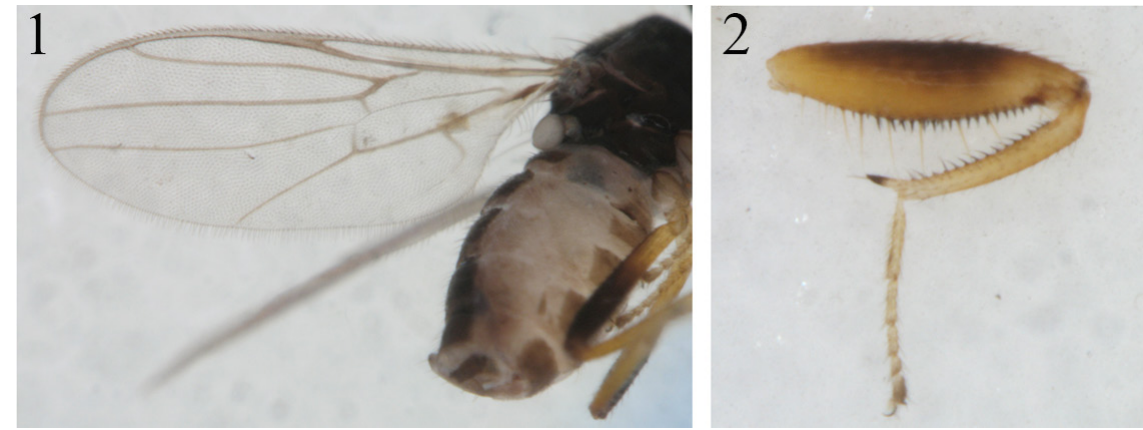
Figs 1–2. Platypalpus bolikoi sp. nov., holotype ♂. 1 . Wing, abdomen and hind femur. 2 . Mid femur, posterior